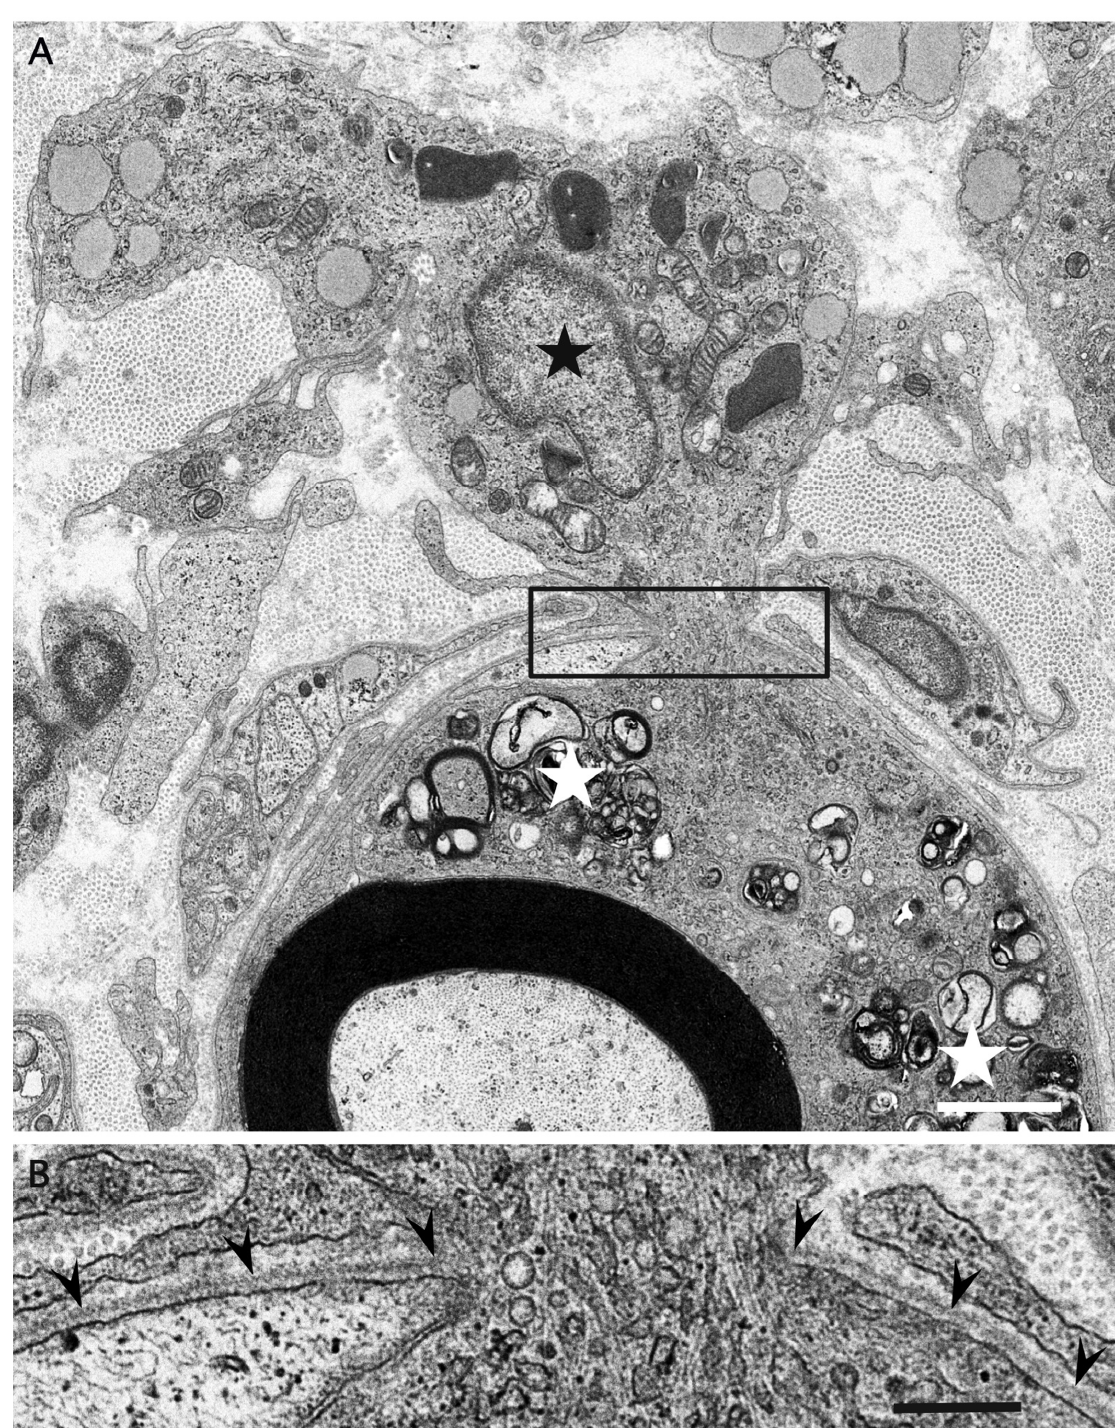
Figure 2. A macrophage invading the basement membrane tube surrounding the myelinated fiber. A cross section of a sural nerve biopsy specimen obtained from a patient with AIDP. A macrophage whose nucleus is indicated by a black asterisk is invading the basement membrane tube that normally surrounds myelinated fibers. Along with the invasion into the basement membrane tube, the cytoplasm of macrophages apposed to myelin initiates degradation of myelin (white asterisks). Note that the cytoplasm of this macrophage located outside the basement membrane tube does not contain myelin debris. A high-powered view of the region in the box in ( A ) is shown in ( B ). Basement membranes surrounding myelinated fibers are indicated by arrowheads. Uranyl acetate and lead citrate staining. Scale bars = 2 µ m ( A ) and 0.5 µ m ( B